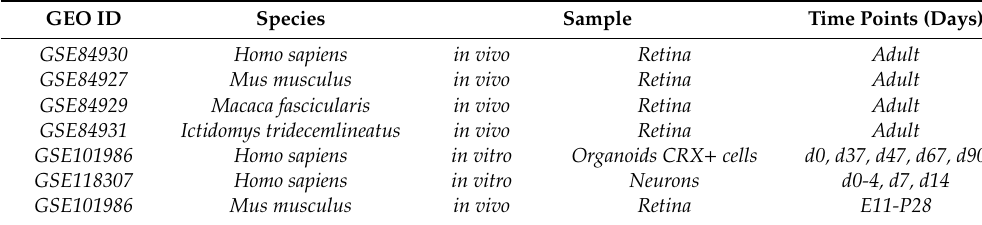
Table 2. Bulk RNA sequencing datasets.